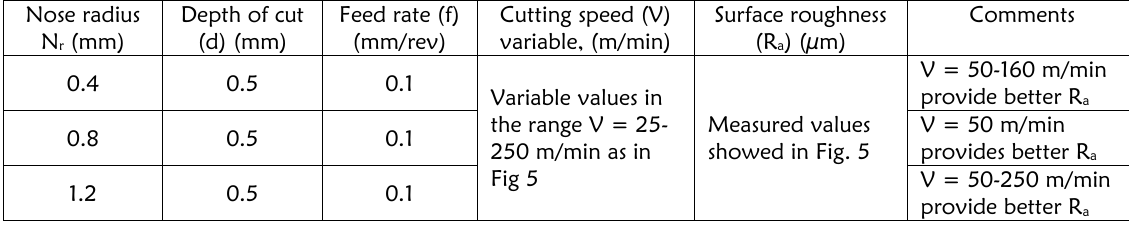
Table 1: Operational data for cutting speed